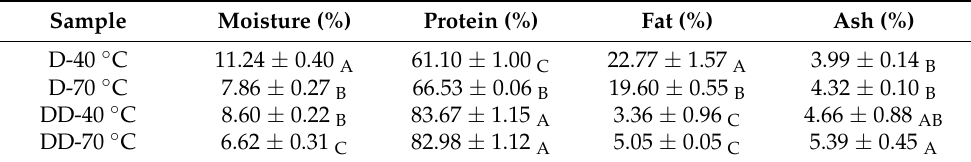
Table 2. Chemical composition of porcine liver dried at 40 ◦ C (D-40 ◦ C) and 70 ◦ C (D-70 ◦ C) and subsequently defatted (DD-40 ◦ C and DD-70 ◦ C).